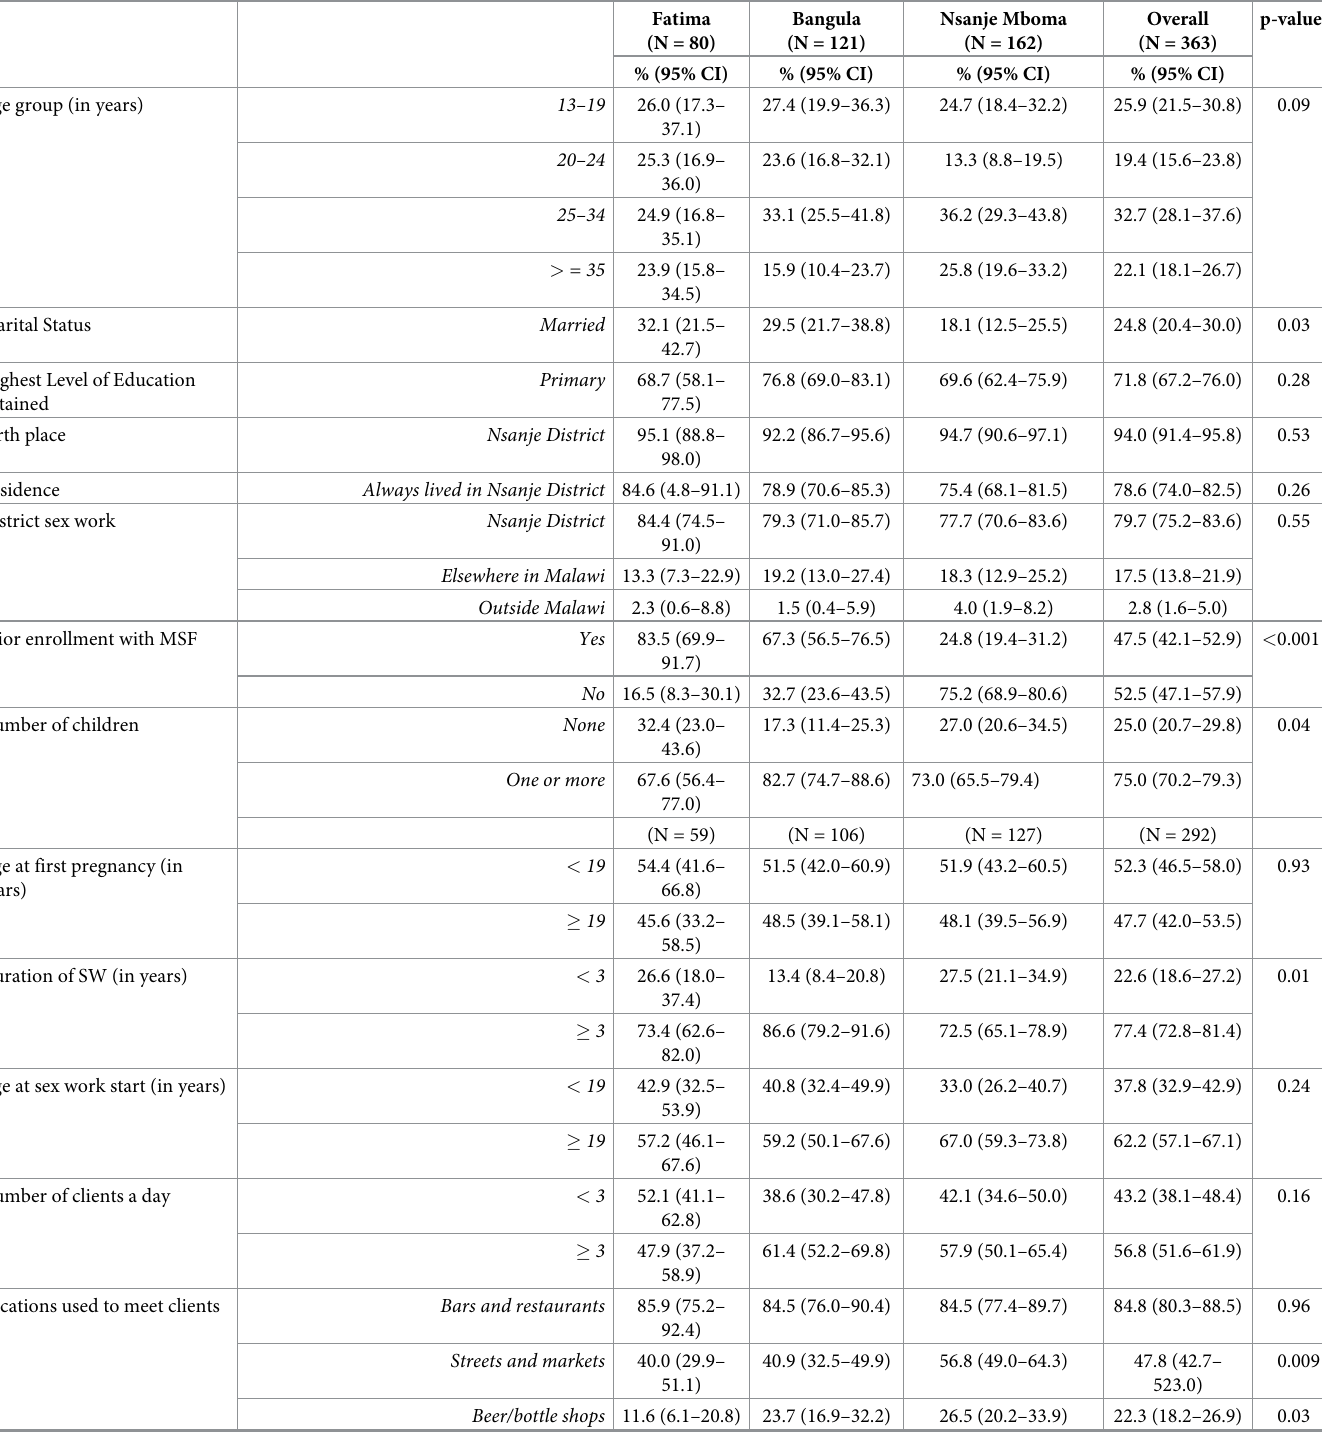
Table 2. Socio demographic and work characteristics of the study population of